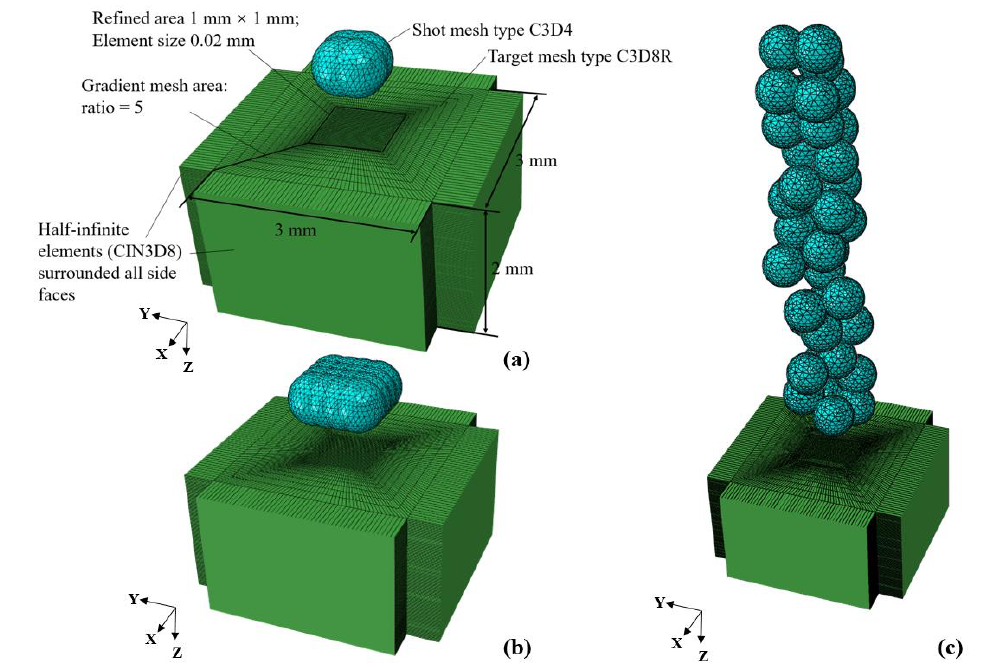
Figure 1. Schematic diagram of SP models: ( a ) The ordered dimple pattern model consisted of 4-shots; ( b ) The ordered dimple pattern model consisted of 16-shots; ( c ) The stochastic dimple pattern model consisted of 38-shots.